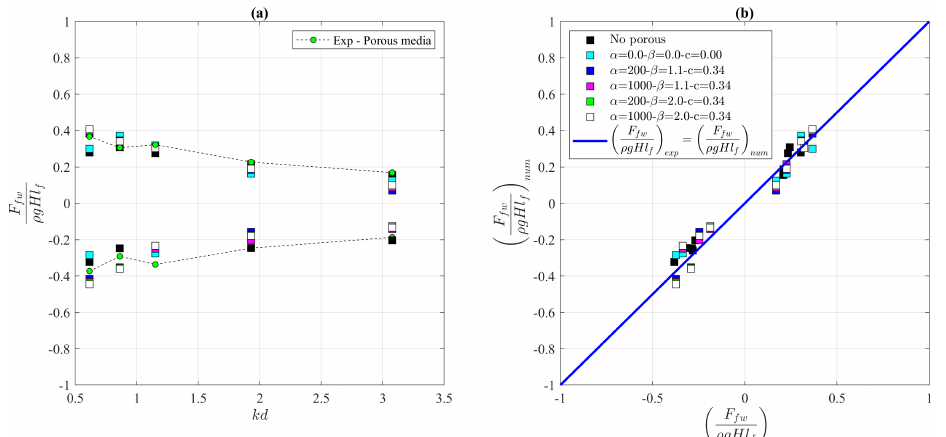
Figure 11. Comparison between the wave loading at the front wall estimated from the experimental data and that estimated from the numerical model: ( a ) dimensionless wave loading as a function of kd ; ( b ) F fw , exp vs. F fw , num